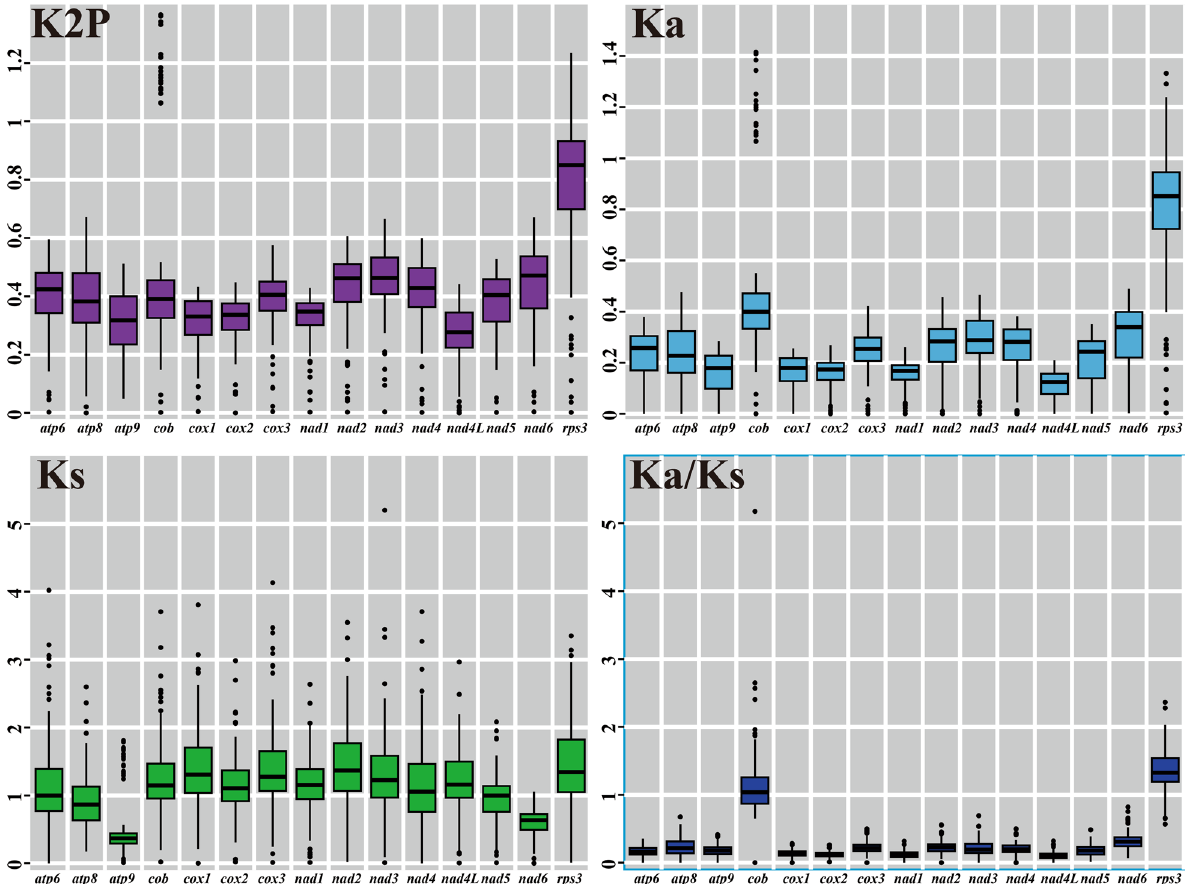
Fig. 5 Genetic analysis of 15 protein coding genes conserved in 19 mitogenomes from Agaricomycotina, Pucciniomycotina and Ustilaginomycotina . K2P, the Kimura-2-parameter distance; Ka , the mean number of nonsynonymous substitutions per nonsynonymous site; Ks , the mean number of synonymous substitutions per synonymous